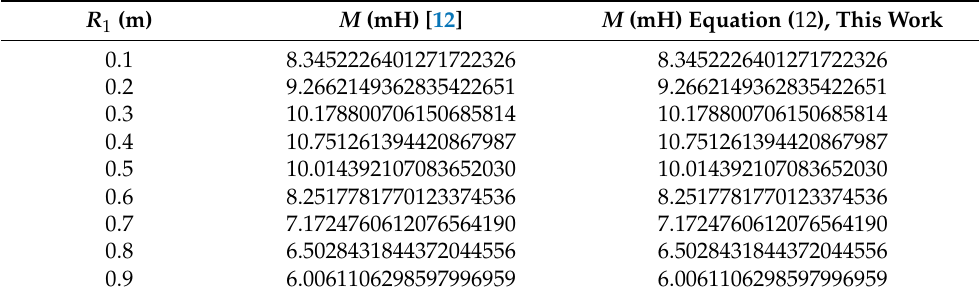
Table 5. Mutual inductance for all overlap